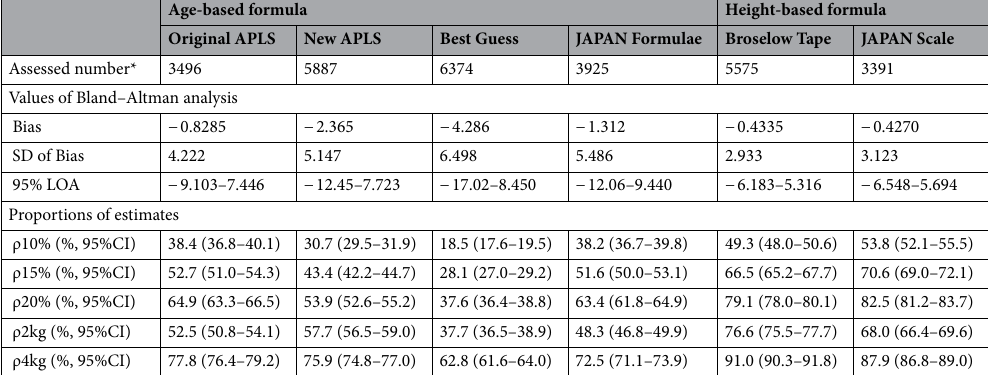
Table 3. Accuracy of each bodyweight estimation formula. LOA; limits of agreement; SD: standard deviation; ρ: proportion of estimates within indicated fraction of the measured weight, or within indicated bodyweight range; CI: confidence interval. *The assessed numbers are different depending on the formulae because the covered age/height range varies (see Supplemental material